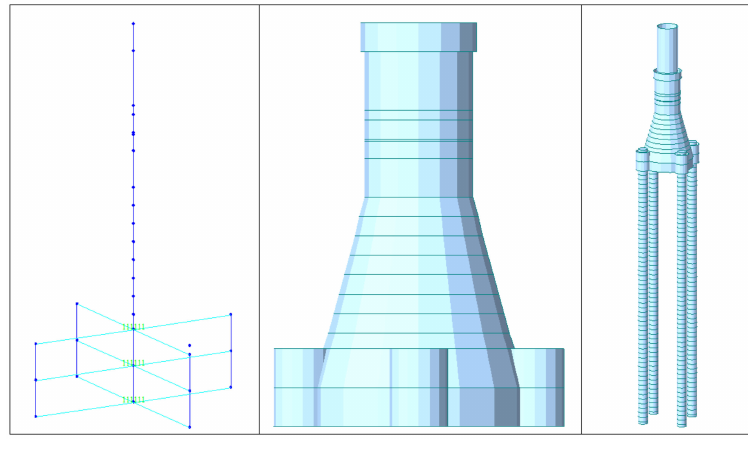
Figure 6. Model of the CCSS.